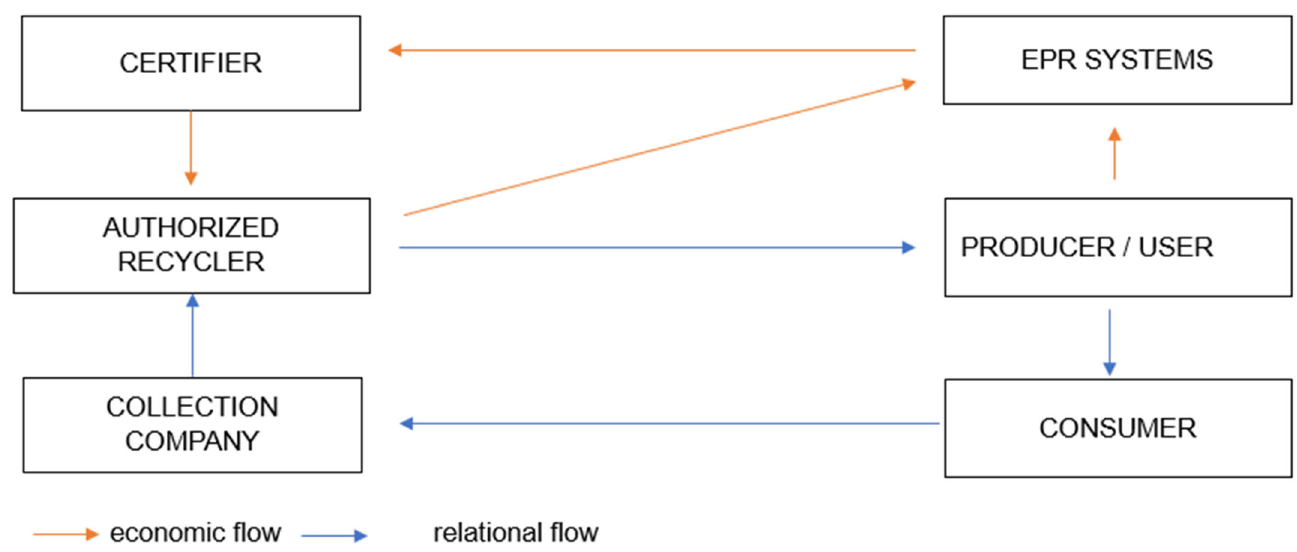
Figure 3. UK model. Source: own elaboration based on [31].